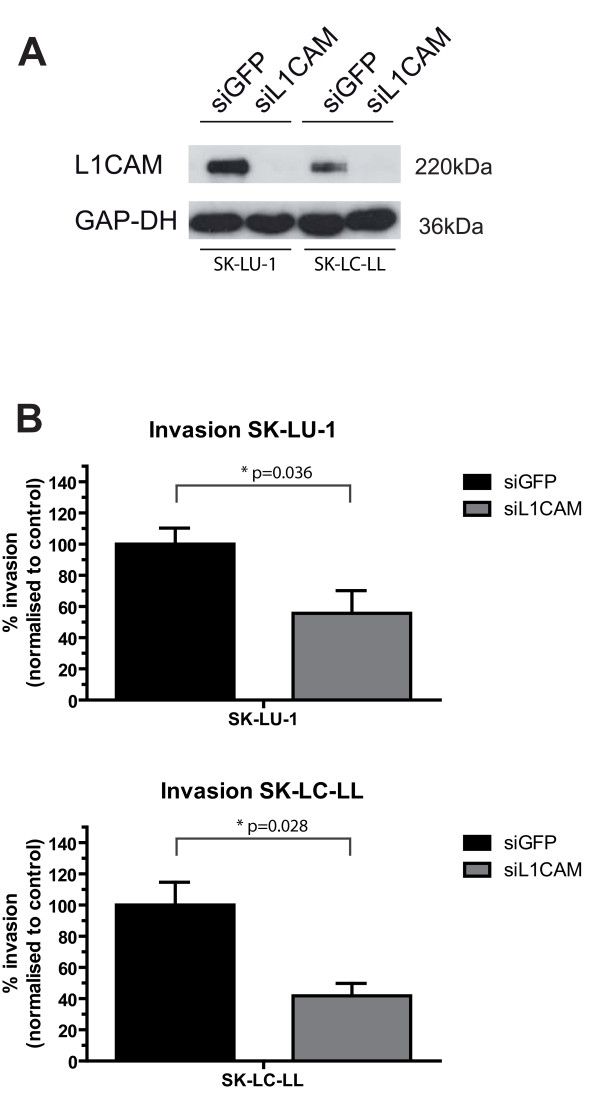
SiRNA knockdown reduces matrigel invasion. A) SiRNA knockdown suppresses L1CAM expression in SK-LU-1 and SK-LC-LL cells. B) L1CAM siRNA knockdown significantly reduces matrigel invasion of SK-LU-1 and SK-LC-LL cells. The error bars represent mean values ± SEM. One representative experiment of n = 3 is shown.